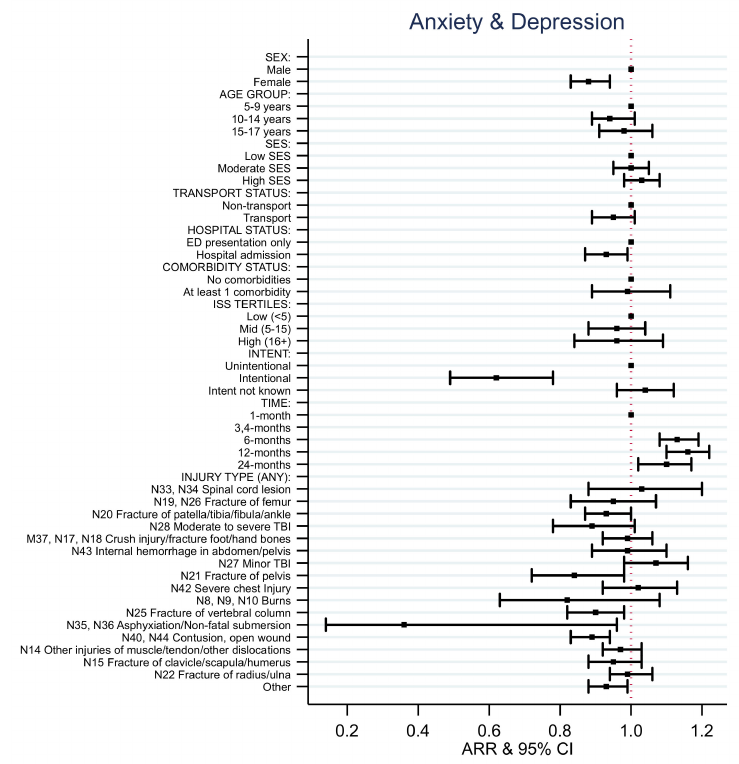
Figure 8. EQ-5D anxiety and depression adjusted relative risk